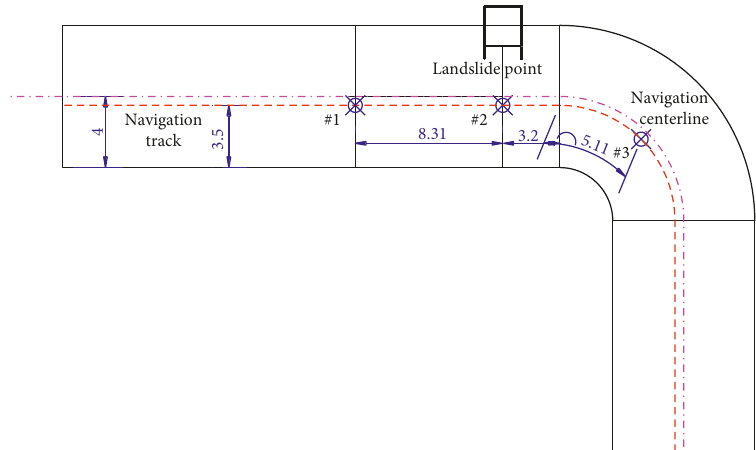
Figure 5: Route and layout of measuring points.